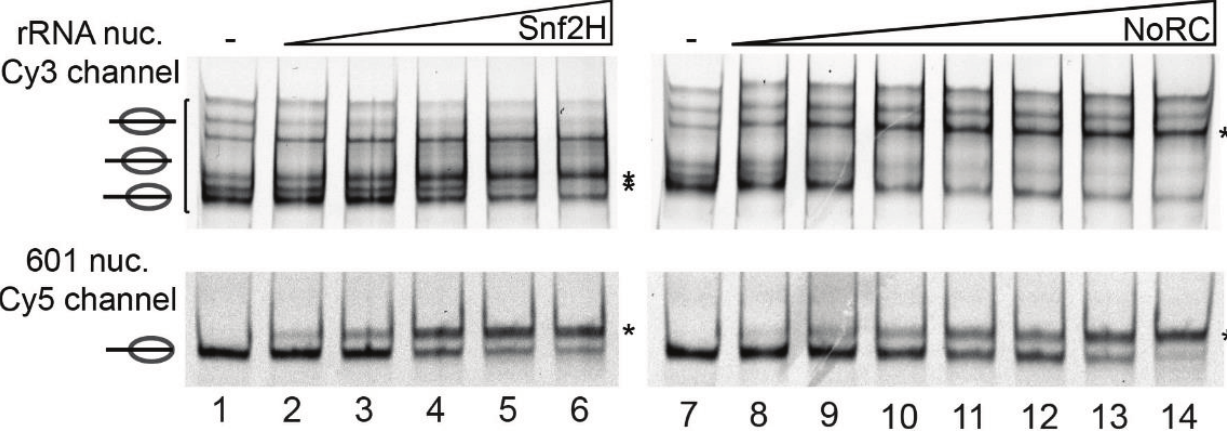
Figure 2. DNA-sequence and the subunit composition of the chromatin remodeling complexes determine the affinity and outcome of the reaction. The 280 bp ribosomal RNA gene promoter sequence and the 208 bp 601 sequence were reconstituted into the nucleosomes using the salt dialysis method. The rRNA gene promoter sequence exhibits several translational positions of the nucleosome, whereas the 601 exhibits a single nucleosome position, as described (lane 1). The differentially labeled nucleosomal DNA templates were mixed and either incubated with increasing concentrations of Snf2H or NoRC in the presence of ATP (lanes 2 – 6 and 7 – 14) [55]. Nucleosome positions were analyzed by native polyacrylamide gel